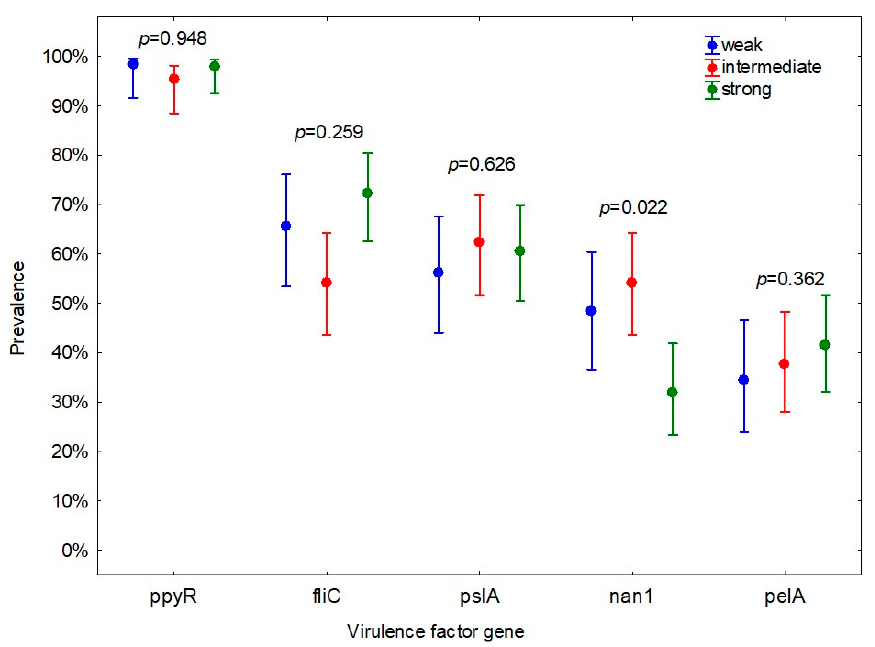
Figure 3. Prevalence (CI 95%) of virulence factor genes in biofilm-forming Pseudomonas aeruginosa strains with weak ( n = 64), intermediate ( n = 85), and strong ( n = 94) biofilm-forming ability.